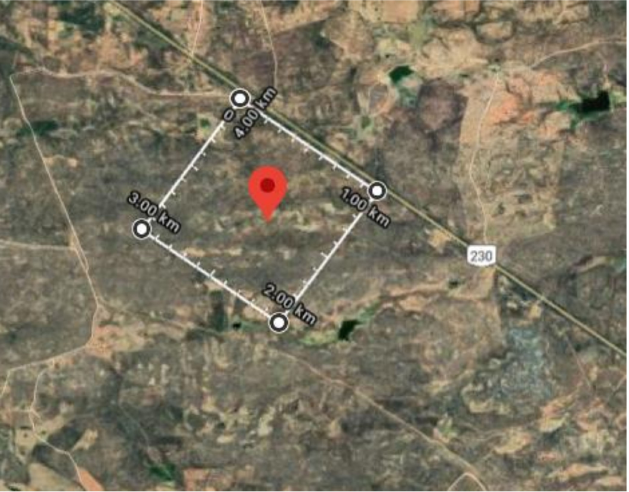
Figure 1. Determination of the photovoltaic solar plant location. Source: